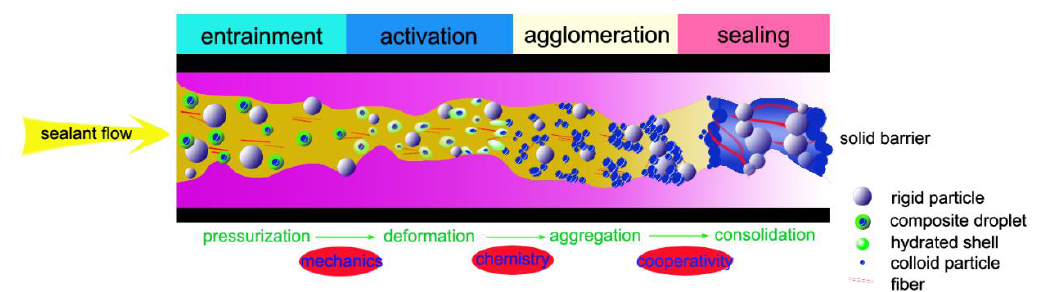
Figure 8. Mechanism of enhancing the in-situ sealing of a composite pressure-activated sealant in a leak defect.